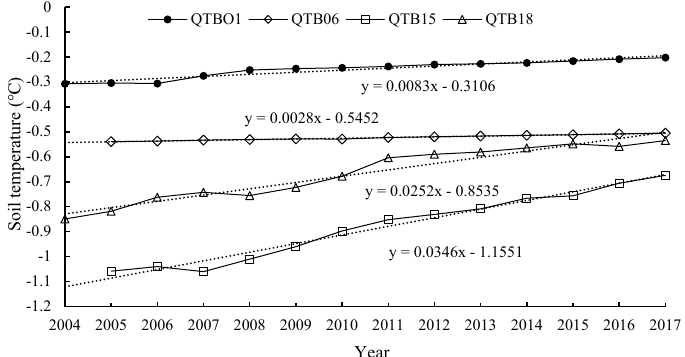
Figure 8. The change in soil temperature at 15 m depth of permafrost at four observation sites along the Qinghai–Tibet Highway.